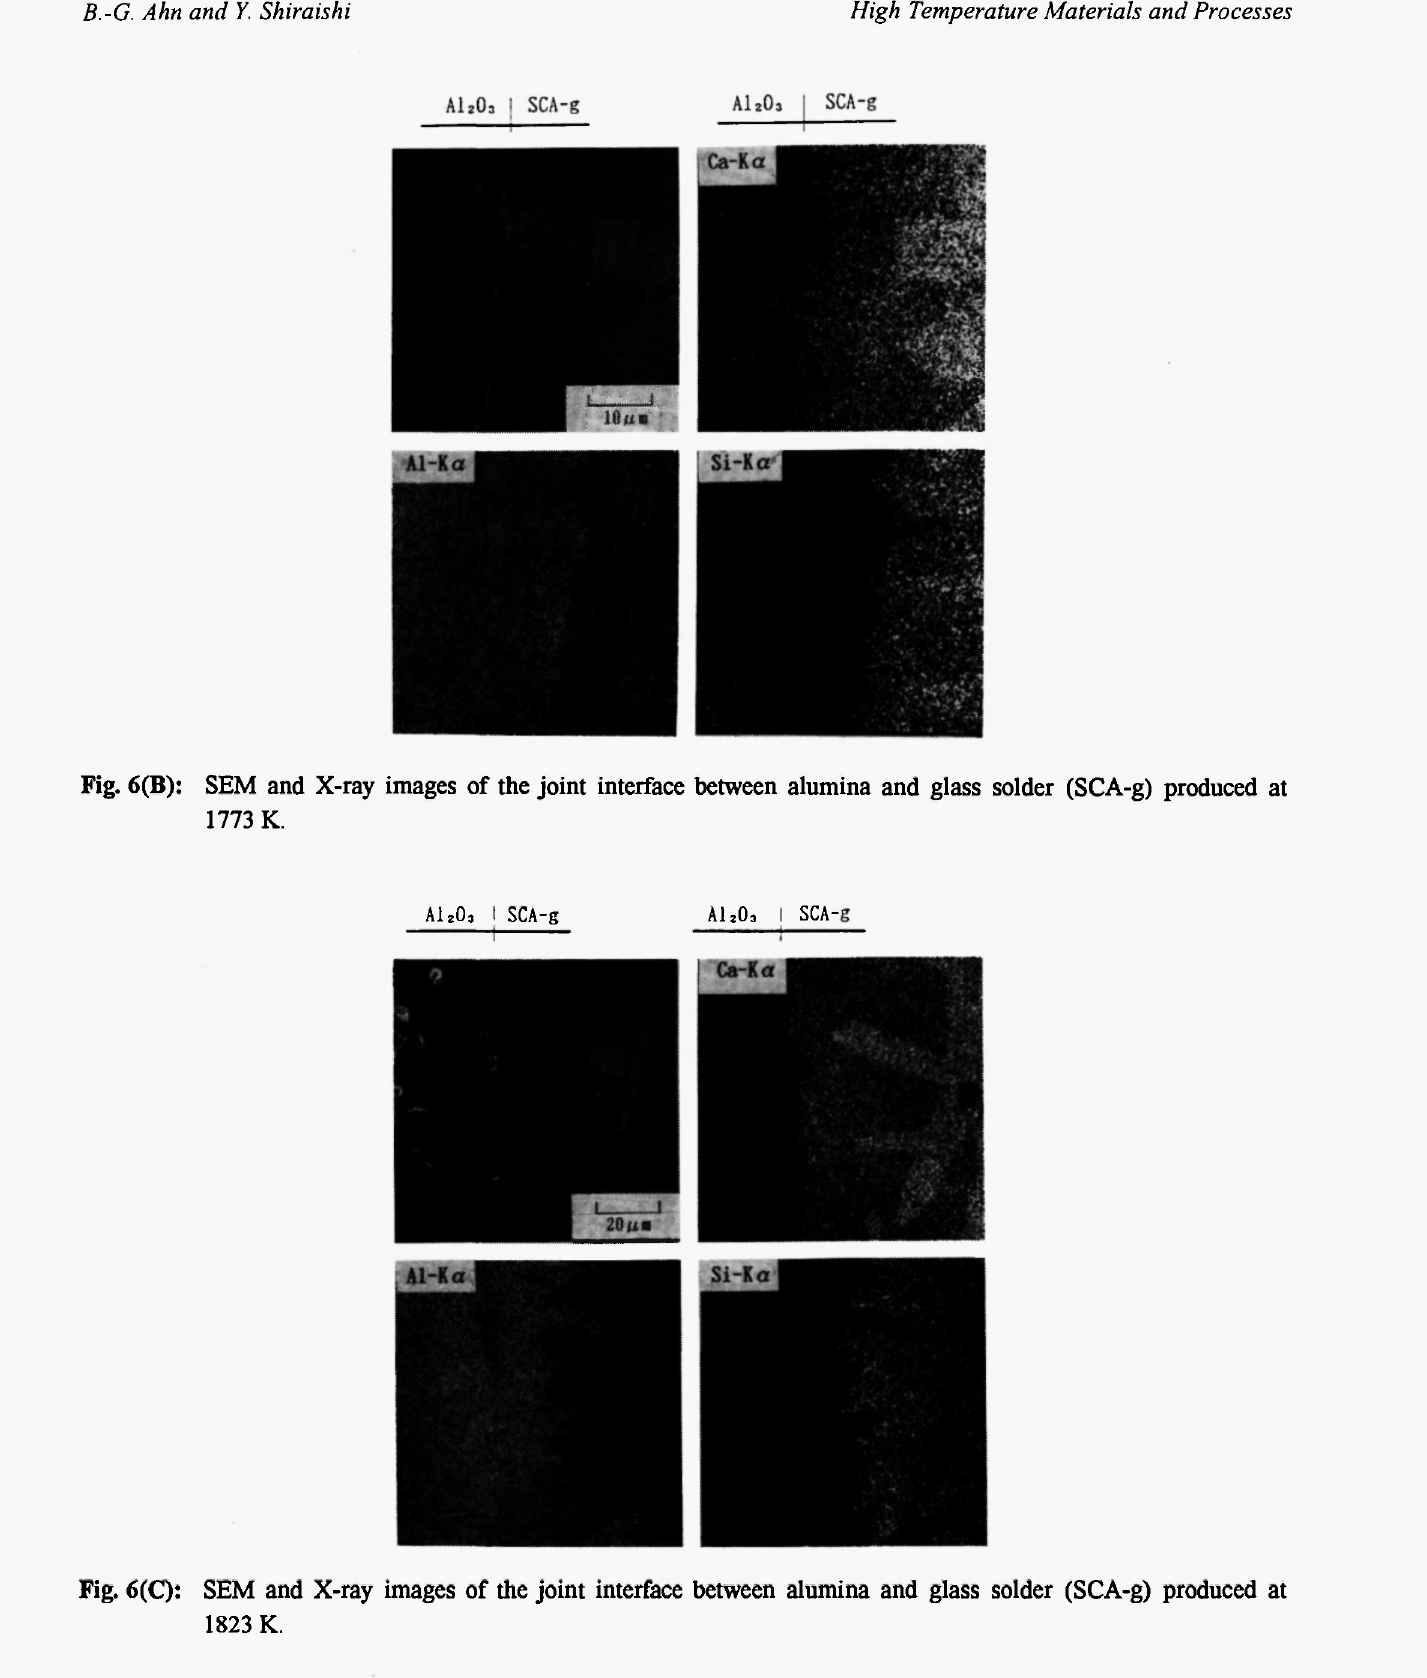
Fig. 6(C): SEM and X-ray images of the joint interface between alumina and glass solder (SCA-g) produced at 1823